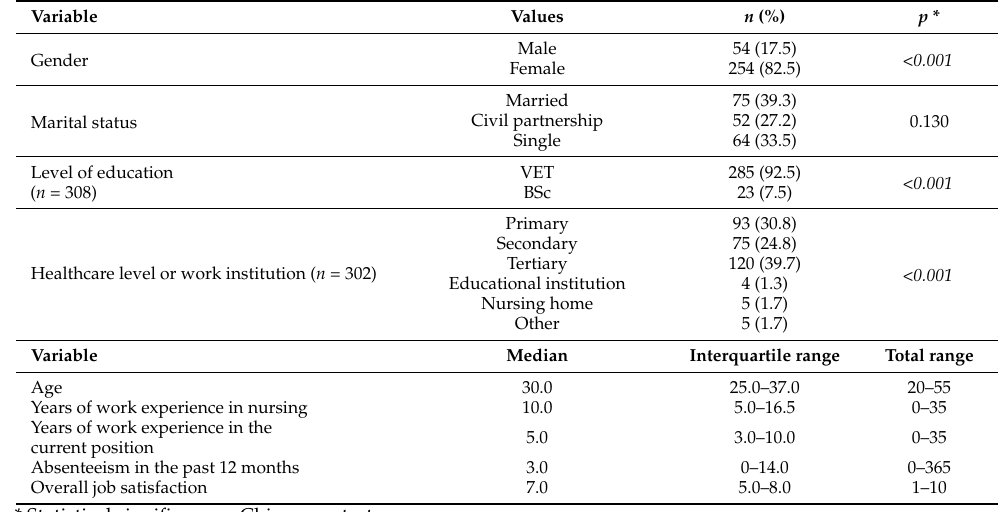
Table 1. Participants’ sociodemographic